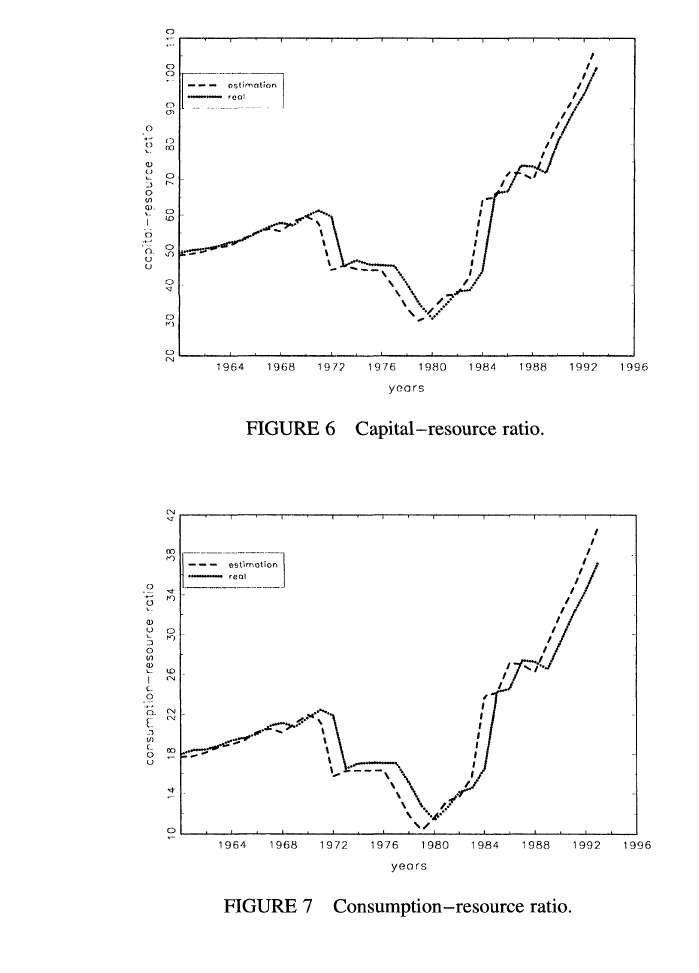
FIGURE 7 Consumption-resource